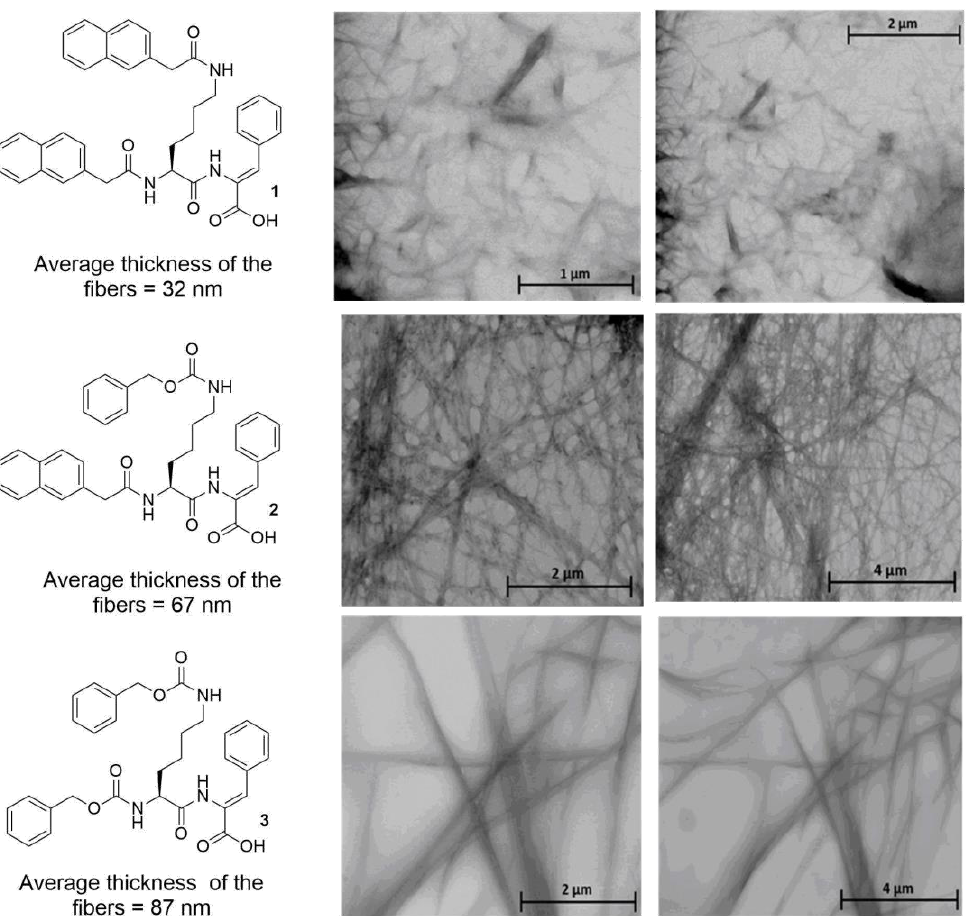
Figure 3. Scanning transmission electron microscopy (STEM) images of hydrogels 1 – 3 at 0.20 wt%.